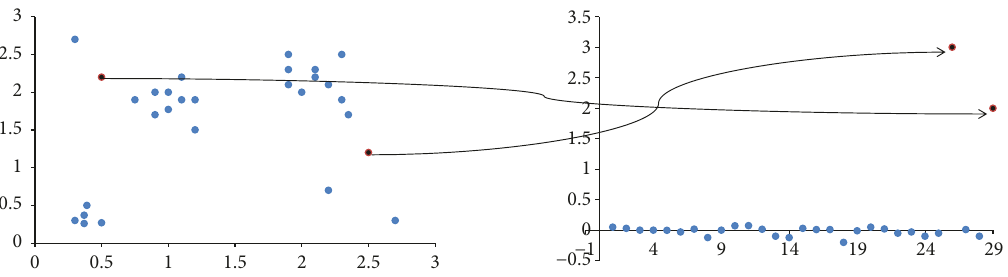
Figure 7: The corresponding points of pending points.